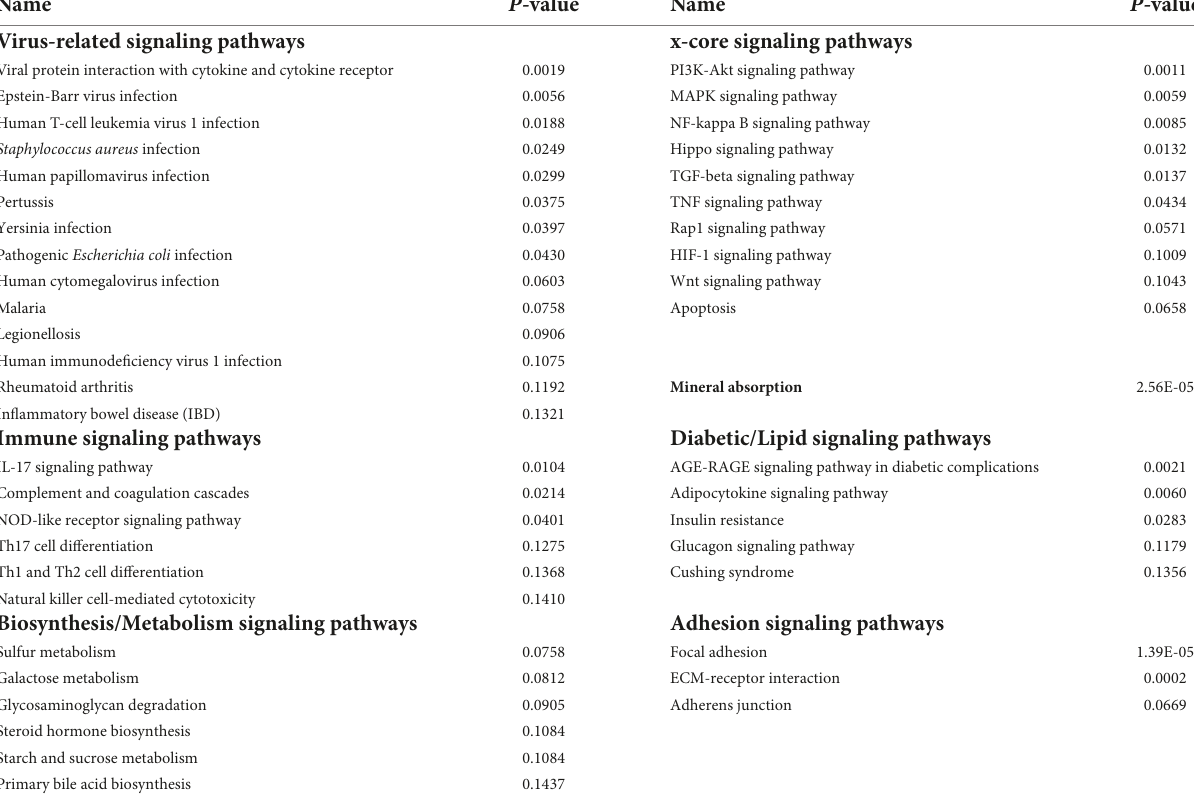
TABLE 4 The seven categories of enriched kyoto encyclopedia of genes and genomes (KEGG) signaling